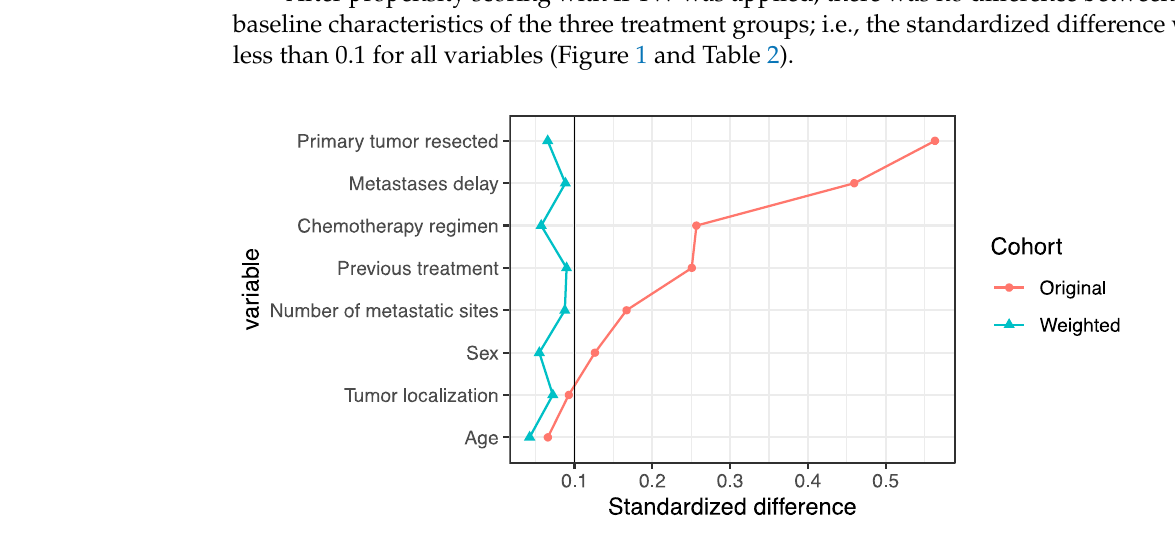
Figure 1. Standardized difference before and after propensity score weighting. The level of balance between the treatment groups was verified by computing the standardized differences. The standardized difference compares the difference in means in units of the pooled standard deviation. Three pairwise standardized differences were computed between the three treatment groups. A standard difference that is less than 0.1 has been taken to indicate a negligible difference between treatment groups. Table 2. Baseline characteristics in the weighted study population.